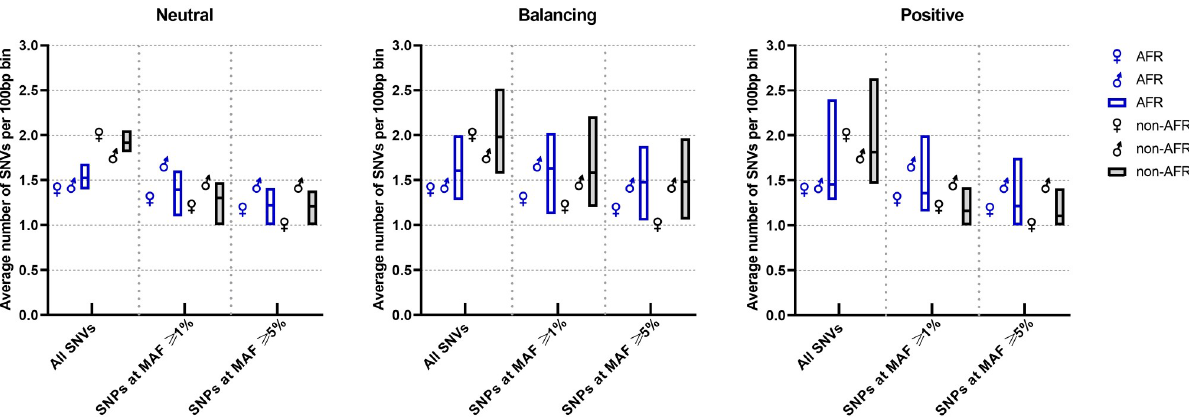
Fig 1. Average number of SNVs per 100bp bin in African (blue) and non-African population (black) groups for genes previously categorized in the literature as selectively neutral, under balancing selection, or under positive selection (these genes as listed in S4 Table along with their classification, and are also used in Tajima’s D and nucleotide diversity analyses). The boxes represent SNV density distribution within each group with the mean marked as a line within the box. IZUMO1 and JUNO are represented by the traditional male and female symbols, respectively. Overall, the total number of SNVs per 100bp bin is higher than the number of SNPs with a MAF � 1% or � 5% in non-Africans compared to Africans, indicating a larger number of rare alleles ((MAF < 1%) in non-African populations. In particular, JUNO in non-Africans has a larger number of rare alleles than